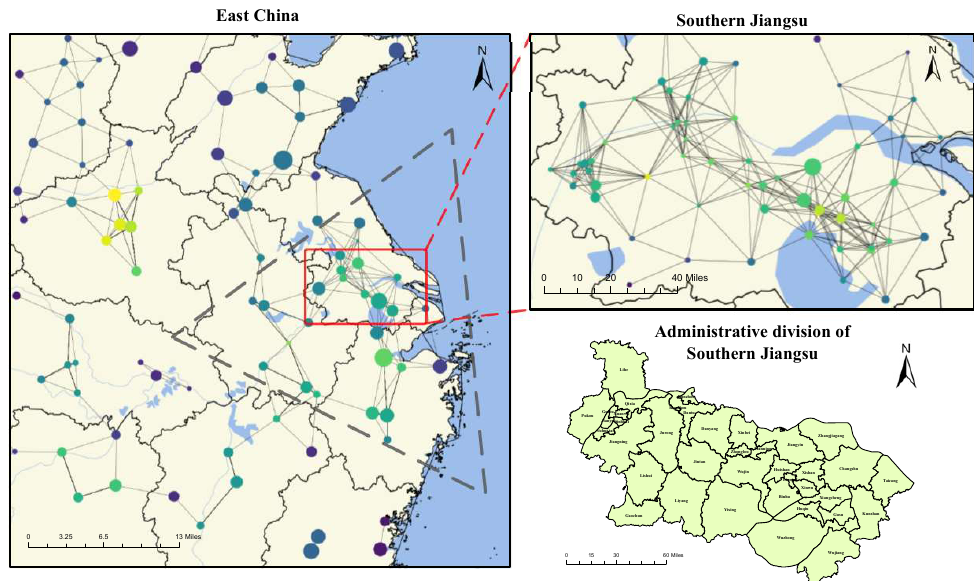
Figure 15. The organizational social network structure in the southern Jiangsu Province. The area framed by the triangle in the left side of the figure is the Yangtze River Delta.